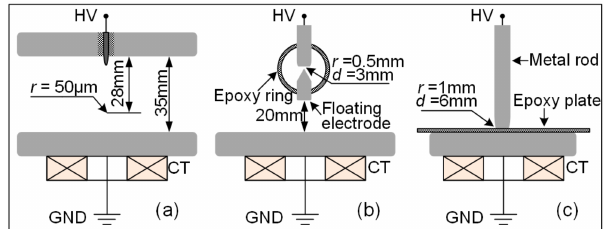
Figure 5. Configurations of the partial-discharge (PD) defect models. ( a ) Metal needle in a quasi-uniform background field; ( b ) Floating-potential metal particle; ( c ) Rod electrode on an epoxy